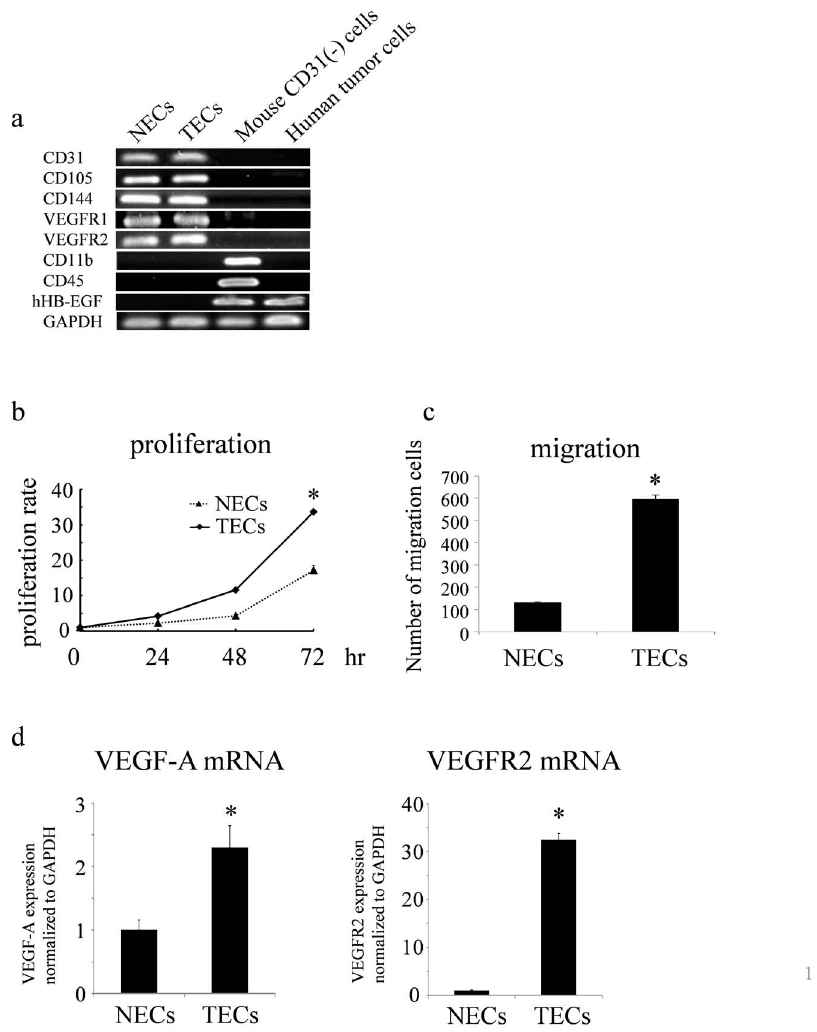
Figure 1. Isolation and characterization of TECs and NECs. a. Cultured TECs and NECs were positive for CD31, CD105, CD144, VEGFR1, and VEGFR2 as determined by RT-PCR. TECs and NECs were negative for the monocyte marker CD11b and hematopoietic marker CD45. Human HB-EGF expression was detected in human tumor cells but not in TECs or NECs. b. Cell proliferation was measured every day for 3 days by MTS assays (*p , 0.05). c. Cell migration towards VEGF was analyzed using a Boyden chamber. Cells on the filter were fixed and stained with hematoxylin after 4 h of incubation. Cells that migrated to the underside of the filter were counted (*p , 0.05). d. Relative expression of VEFG-A and VEGFR2 to GAPDH in TECs and NECs was measured using real-time RT-PCR (*p ,